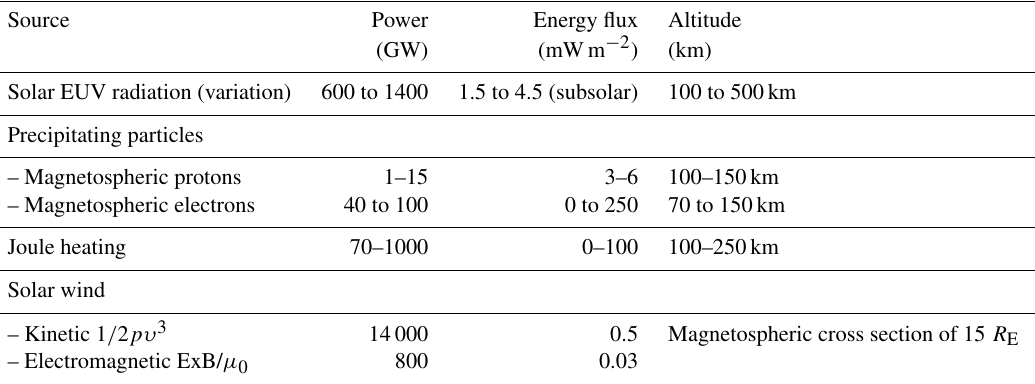
Table 1. Main energy deposition mechanisms and their ranges in the LTI region, as well as the available energy within the solar wind during moderate